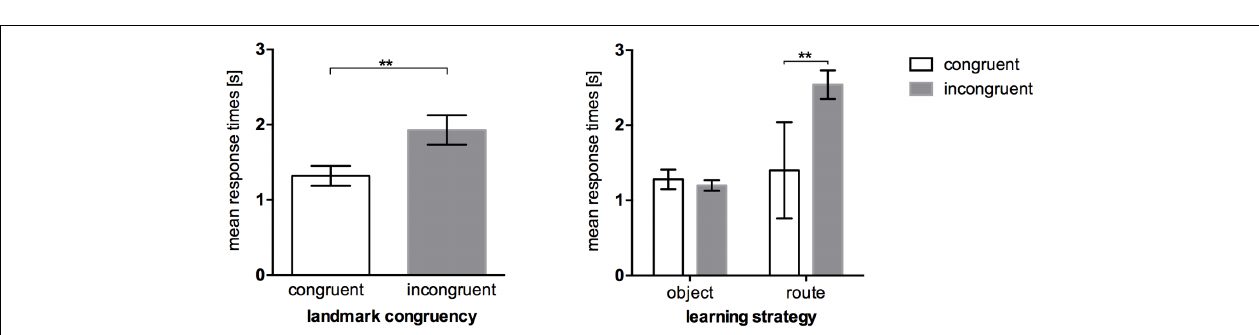
FIGURE 4 | Mean correct recognition performance in Experiment 2, error bars represent the SEM , chance level = 15. (Left) Comparison between recognition performance in the congruent landmark condition and the incongruent landmark condition. (Right) Recognition performance between congruency levels after post hoc categorization of strategies. ∗ p < 0.05; ∗∗ p < 0.01.